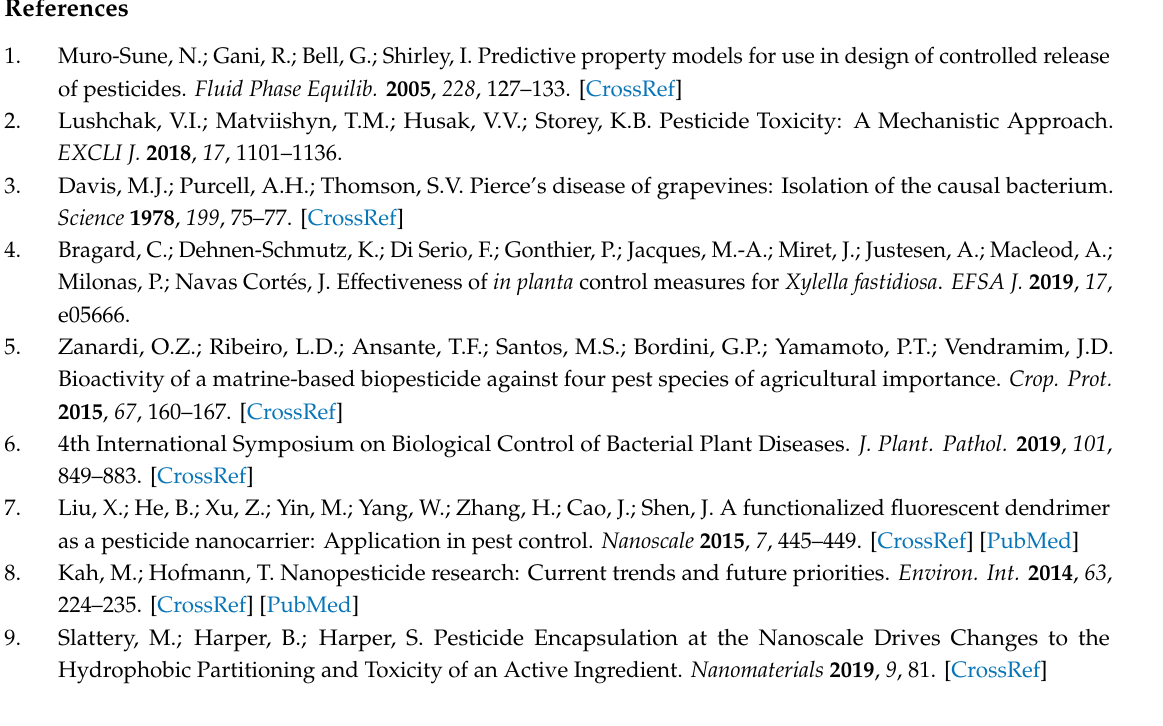
Figure S1: Highly magnified detail of a wrinkled structure in the SEM image of Figure 3D, Figure S2: TEM image of a CH-nanoFos